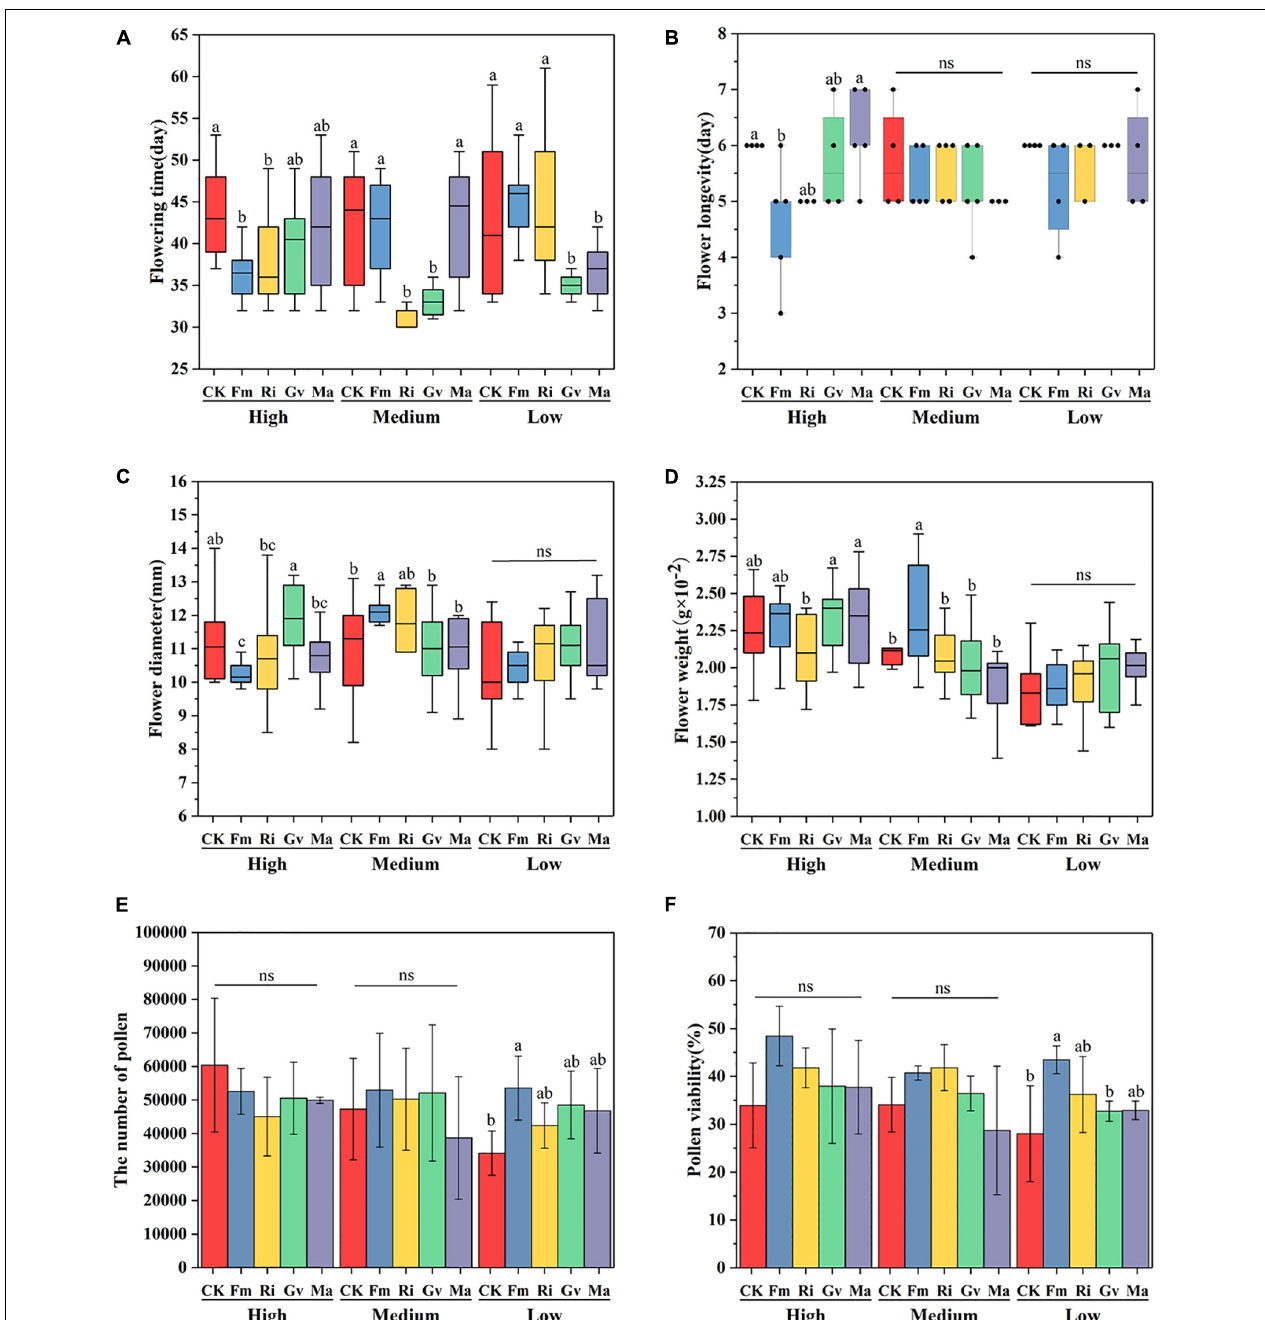
FIGURE 3 | Flowering time (A) , single flower longevity (B) , single flower diameter (C) , single flower weight (D) , pollen quantity (E) , and pollen viability (F) of cherry tomato inoculated with AMF under different nutrient